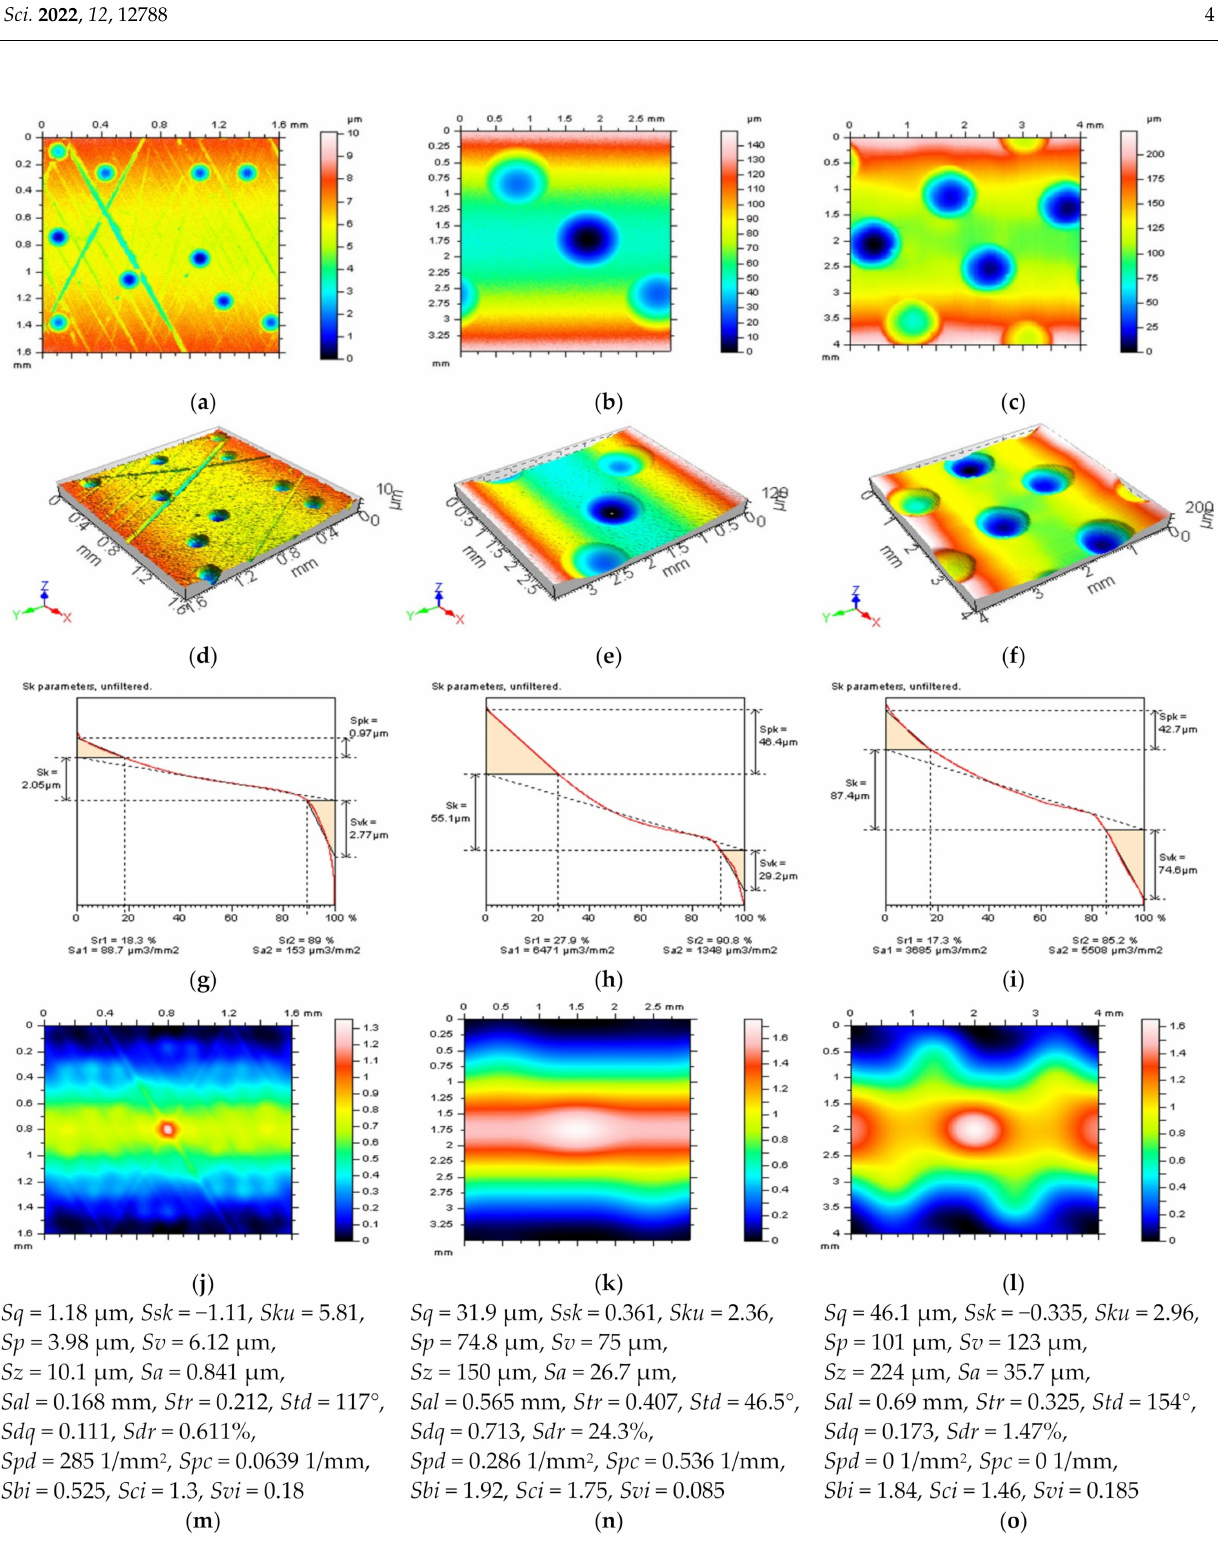
Figure 1. Contour map plots ( a – c ), isometric views ( d – f ), material ratio curves ( g – i ), 3D ACF ( j – l ) and the ISO 25178 surface topography parameters ( m – o ), received from a cylindrical surface with additionally burnished dimples with different sizes and